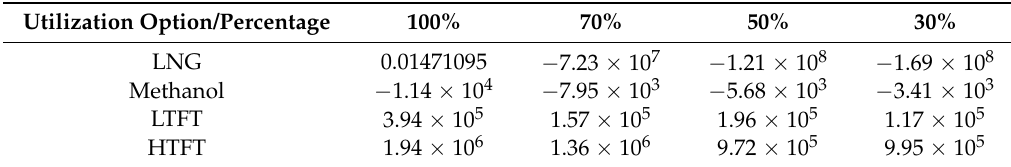
Table 8. CO 2 equivalent values in tons/year for different utilization